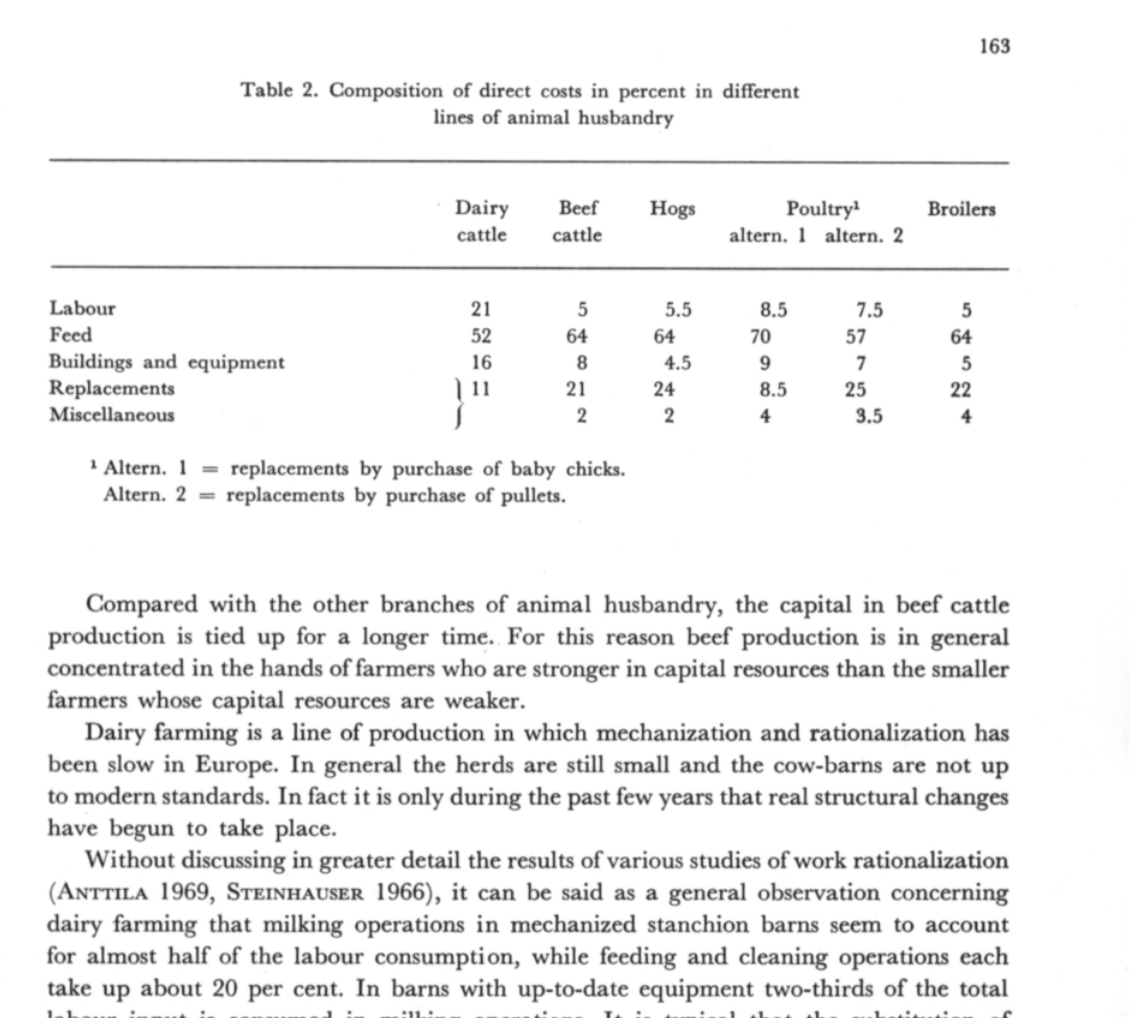
Dairy Beef Hogs Poultry 1 Broilers cattle cattle altern. 1 altern.